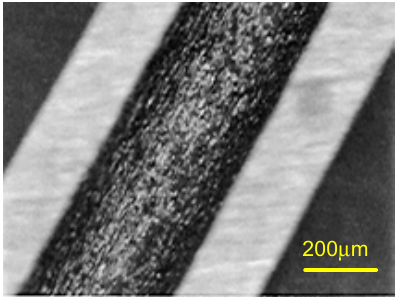
Figure 16. The interior of a corroded tube (#3, 1.4435/316L steel).